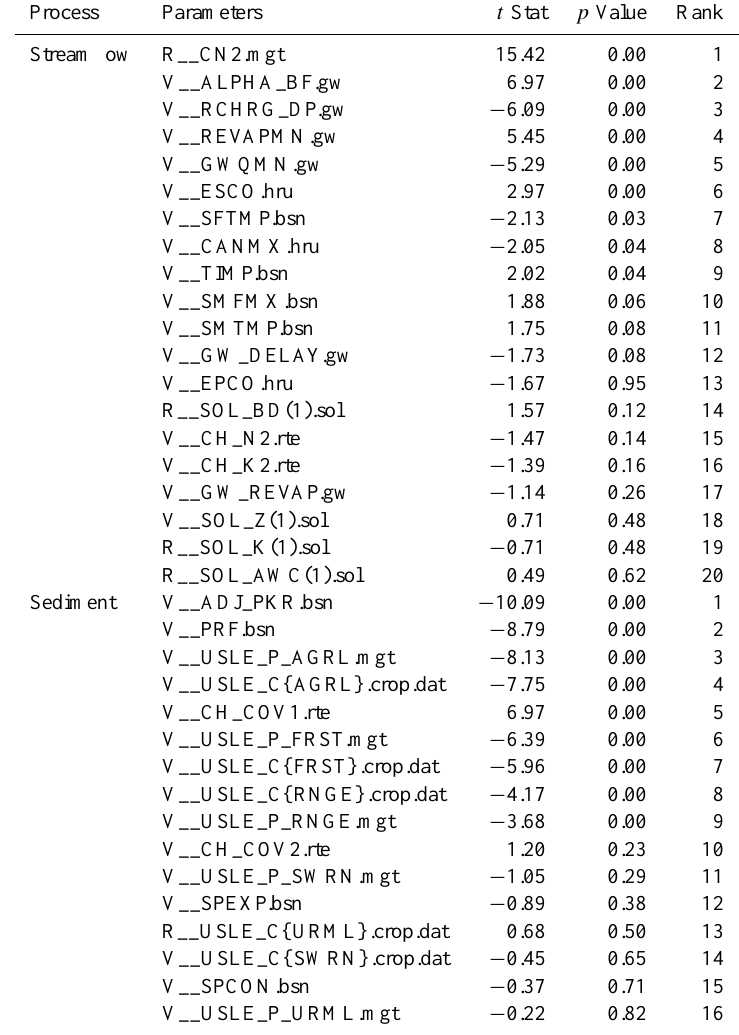
Table 2. Parameters sensitivity results in the Kejie